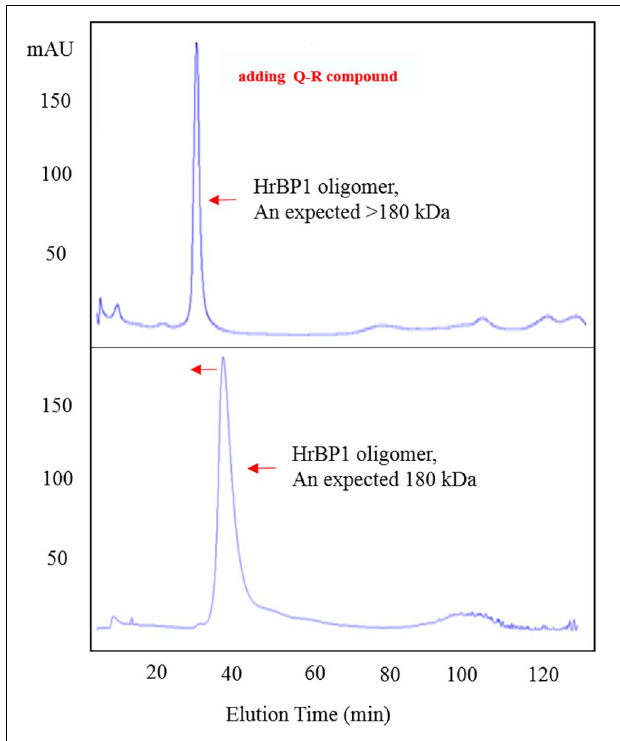
FIGURE 5 | Q-R induced the assembly of HrBP1 large oligomer protein with expected size > 180 kDa between 440 kDa (Ferritin) and 158 kDa